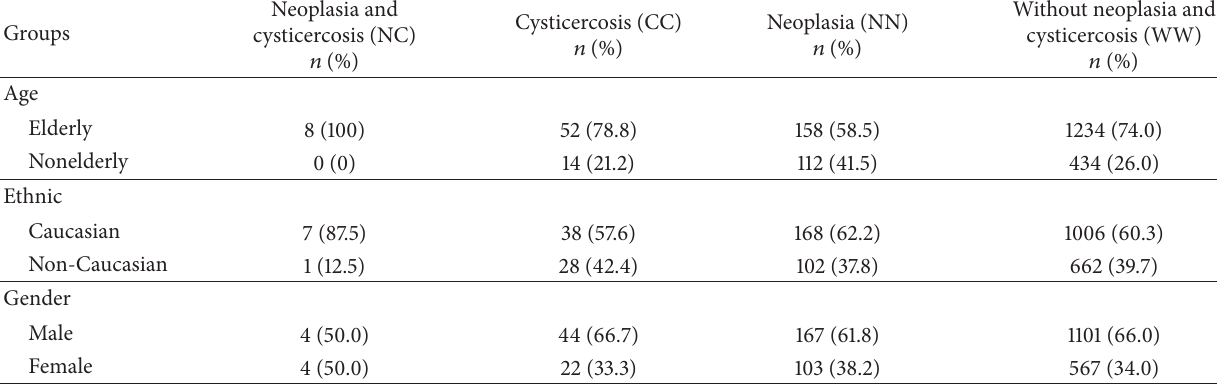
Table 1: Demographic profile of autopsied patients with cysticercosis and/or neoplasia from 1970 to